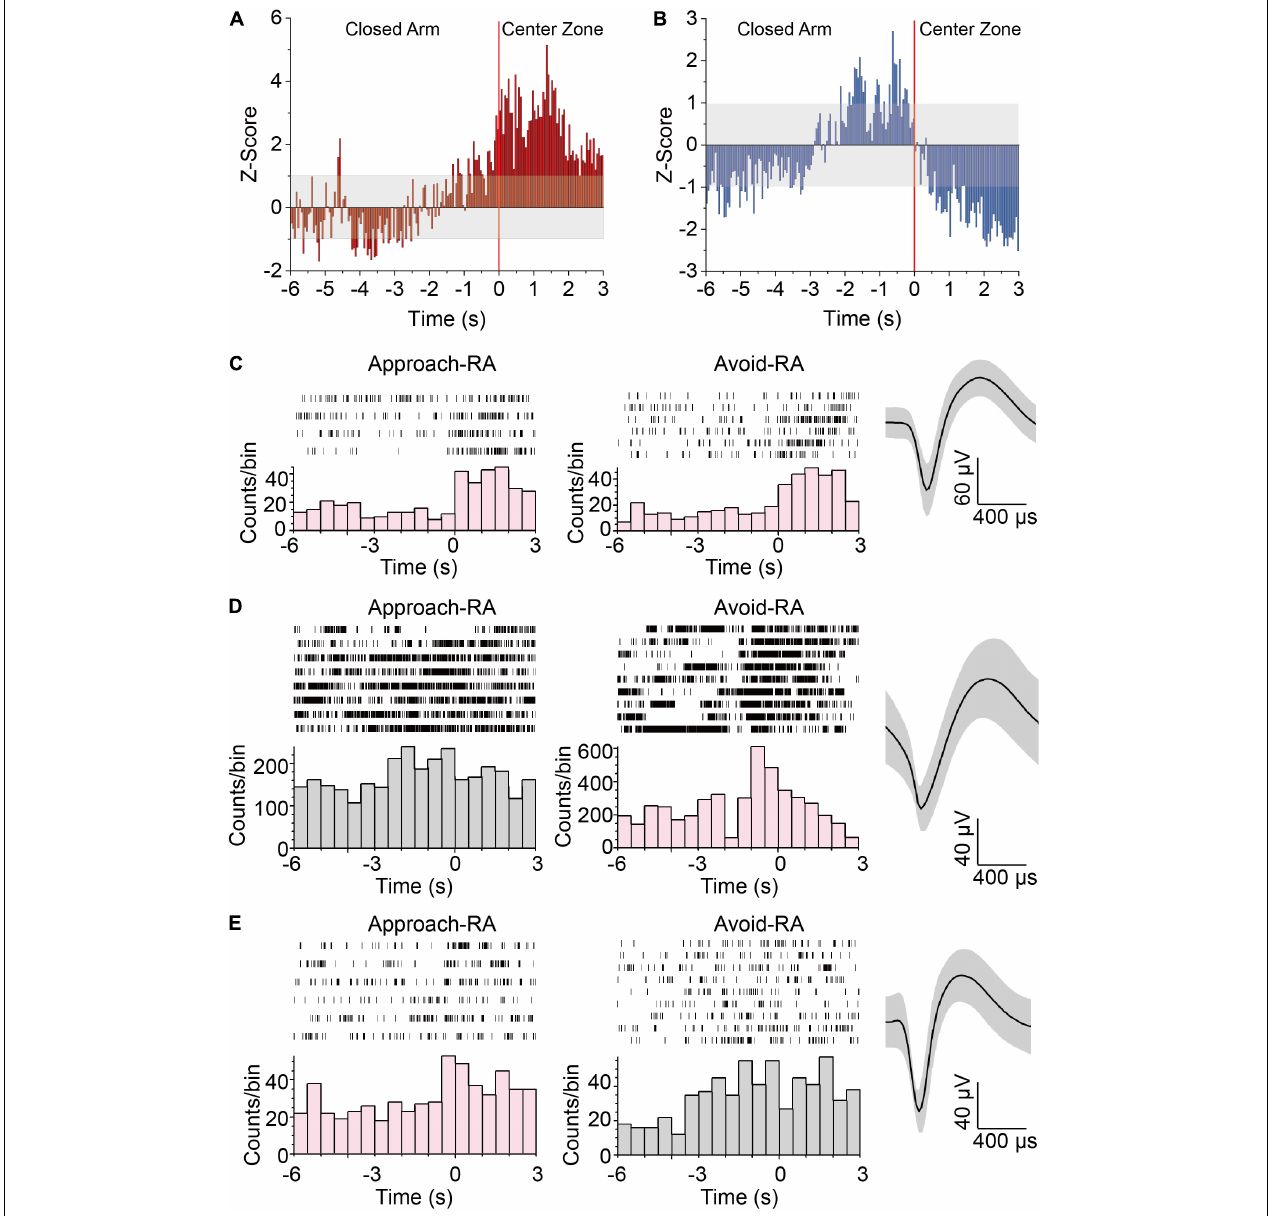
FIGURE 2 | Neurons in HPC responding to approach-RA or avoid-RA selectively. (A,B) Z -scored peri-RA time histograms aligned with onset of RA. (A) n = 57 cells from 5 mice. (B) n = 60 cells from 5 mice. (C) Representative raster plots and waveforms of dDG/CA3 neurons positively responsive to RA. (D) Representative raster plots and waveforms of dDG/CA3 neurons positively responsive to avoid RA. (E) Representative raster plots and waveforms of dDG/CA3 neurons positively responsive to approach RA. Each row in the raster represents a single trial of RA behavior. Averaged spike waveforms of the representative neuron were provided at the left panels. Bin = 0.5